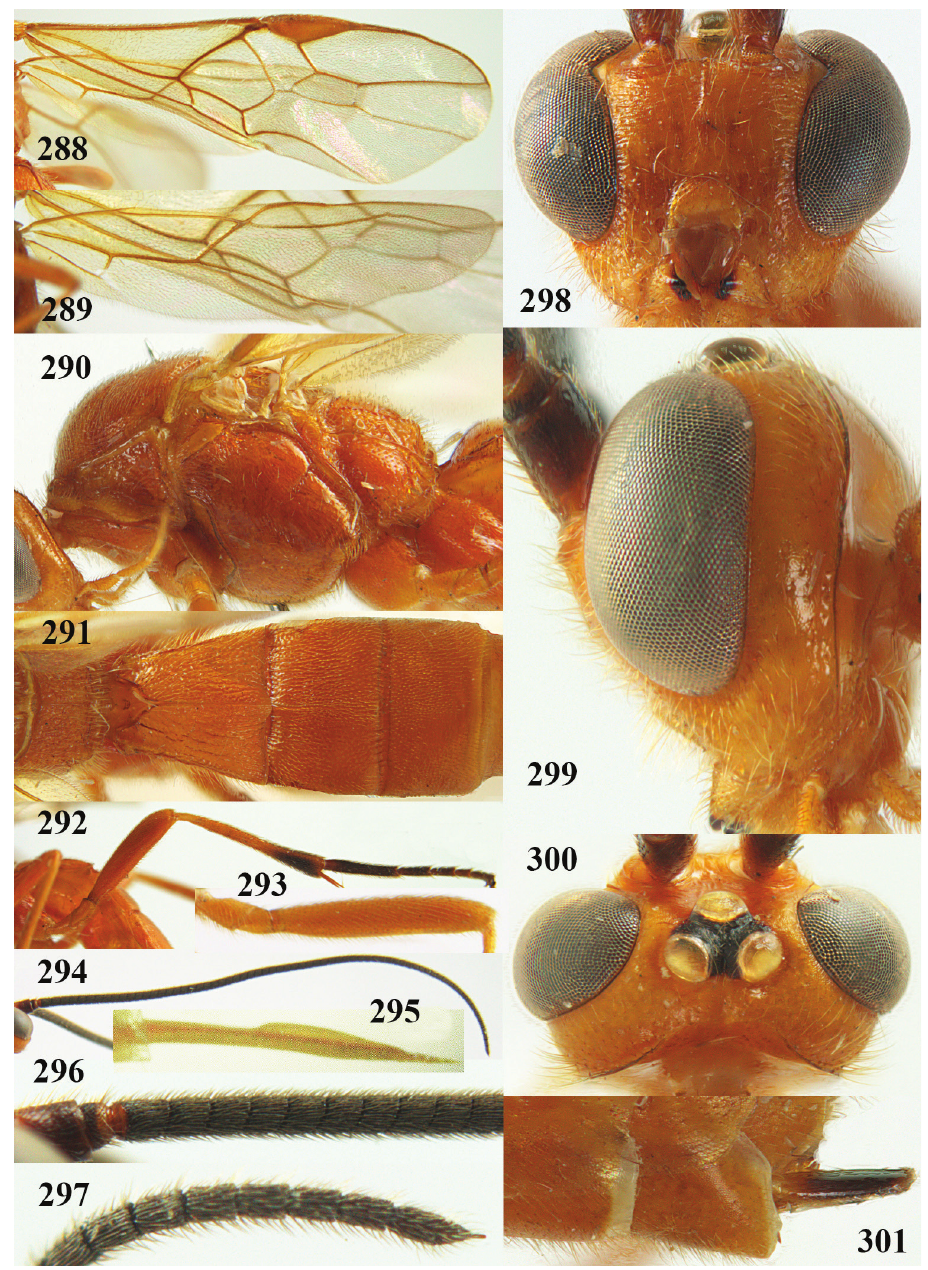
Figures 288–301. Aleiodes praetor (Reinhard), ♀ , Netherlands, Epen. 288 fore wing 289 hind wing